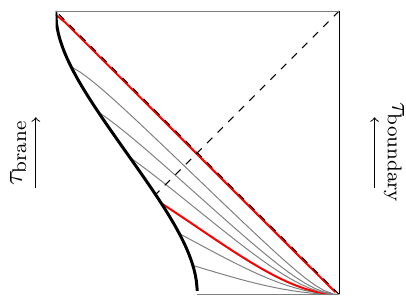
Figure 9 . Extremal surfaces which end on the brane in the case of T 0 = T crit . As can be seen, all such surfaces end at time τ boundary = Schwarzschild time t